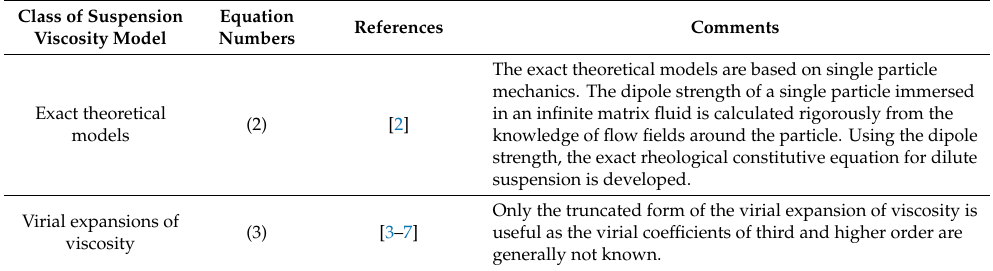
Table 1. Summary and classification of various available suspension viscosity